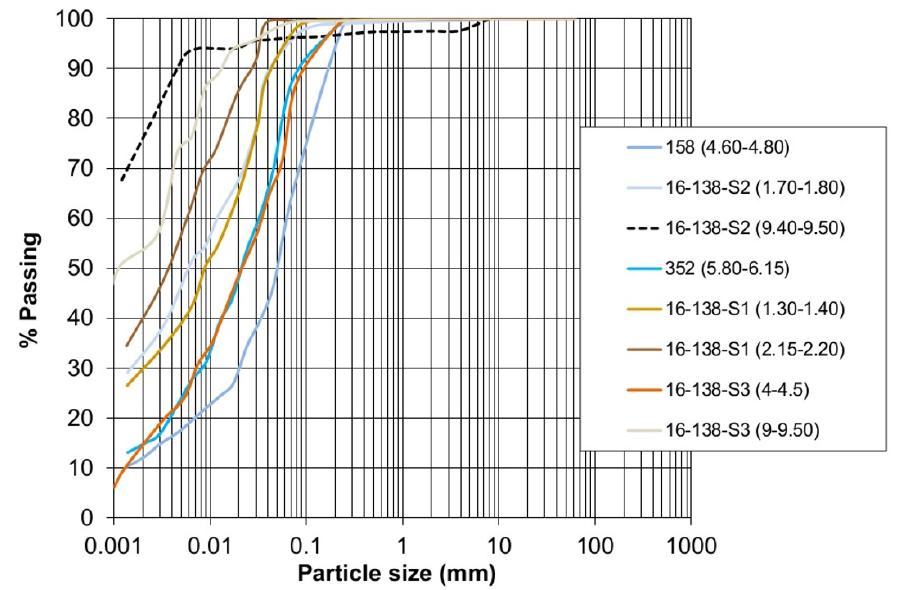
Figure 4. Particle size distribution curves for the clayey silt (La) and clayey sandy silt (Las) in the shallow 10 m from the ground level. The dotted black curve refers to a sample rich in organic matter.